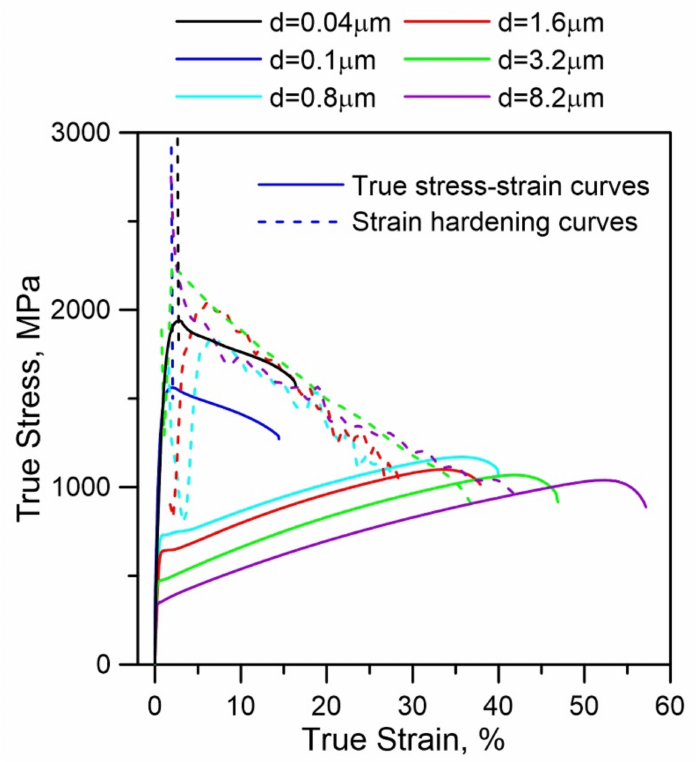
Figure 7. Strain hardening rates of annealed HPT-produced 316LN